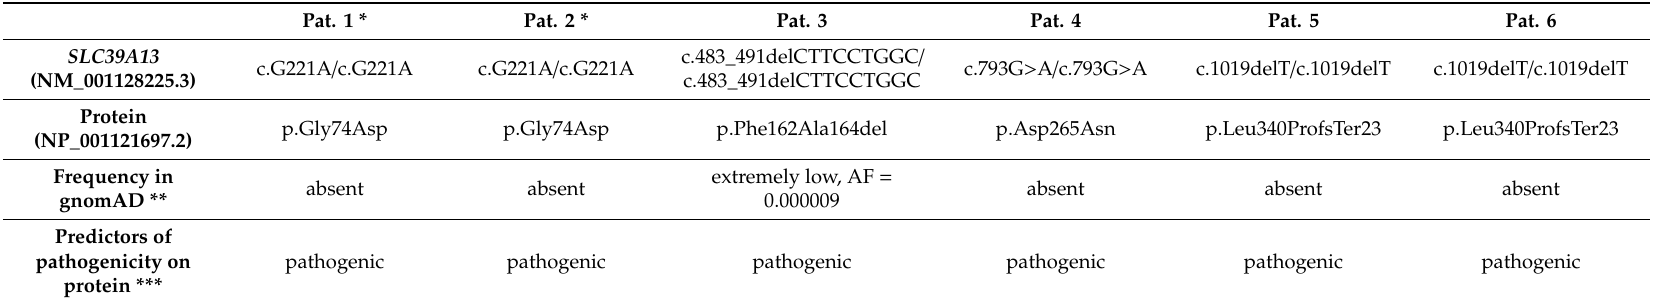
Table 1. Overview of the molecular